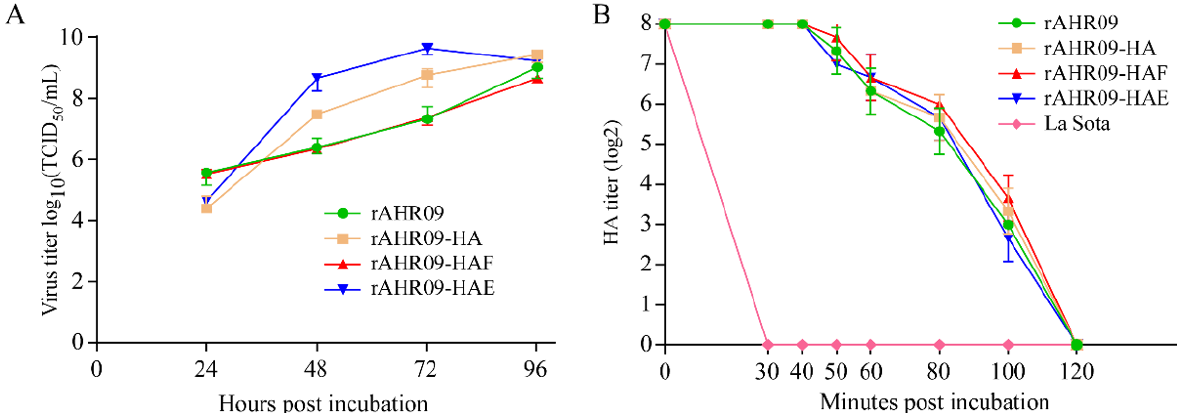
Figure 4. Biological characteristics identification of recombinant NDVs. ( A ) The CEF cells in 6-well plates were incubated with rAHR09, rAHR09-HA, rAHR09-HAF, and rAHR09-HAE at an MOI of 0.1, respectively. The cells’ supernatants were harvested at 24, 48, 72, and 96 hpi, then the virus titer was determined using the TCID 50 method in CEF cells. ( B ) Each NDV recombinant virus was separately incubated for 30, 40, 50, 60, 80, 100, and 120 min under 56 °C. Then, the HA titer of each treated recombinant NDVs was measured.